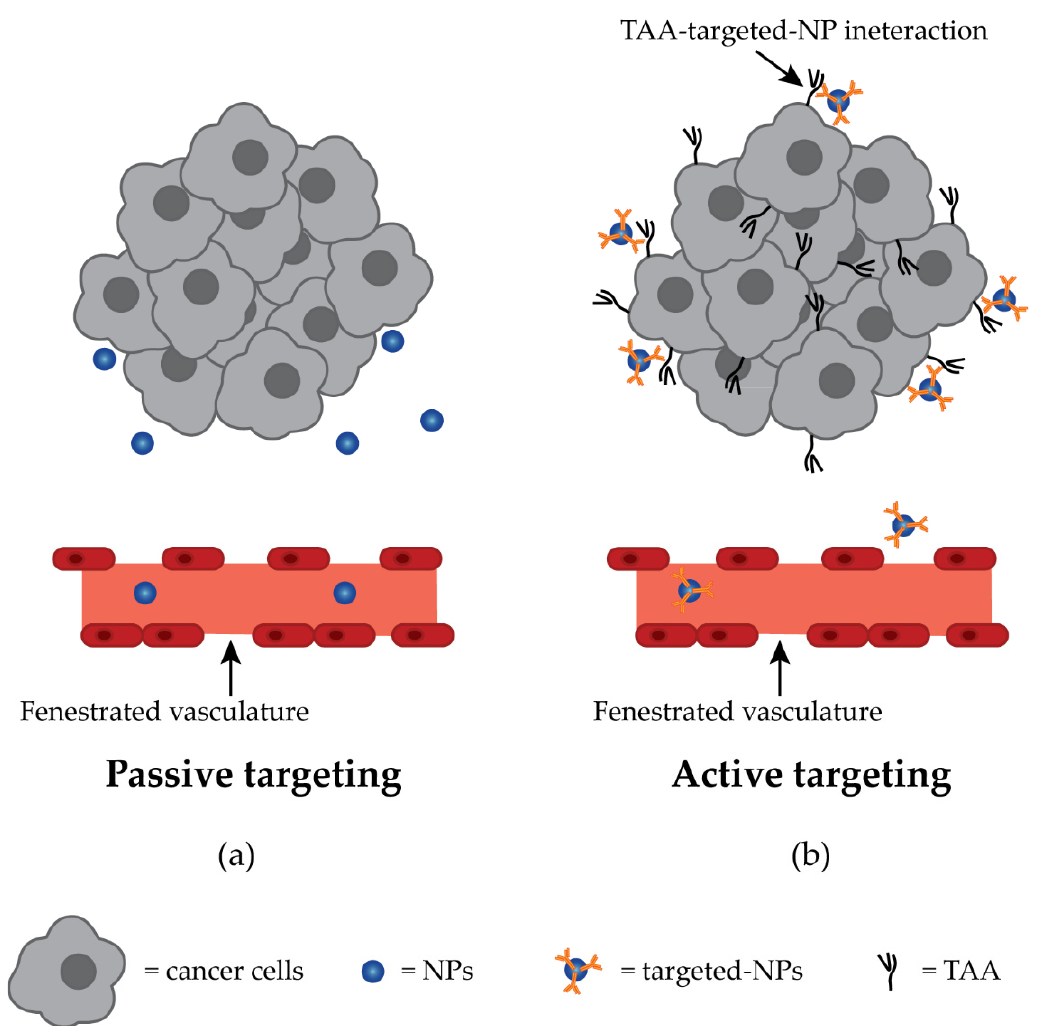
Figure 4. Types of targeting in a drug delivery approach using NPs. ( a ) Leaky and fenestrated vasculature allows the NPs to leave blood circulation and reach the tumor site by passive targeting. ( b ) Active targeting relies on the presence of ligands on the NPs surface, which interact with their TAA, increasing NPs’ specificity.